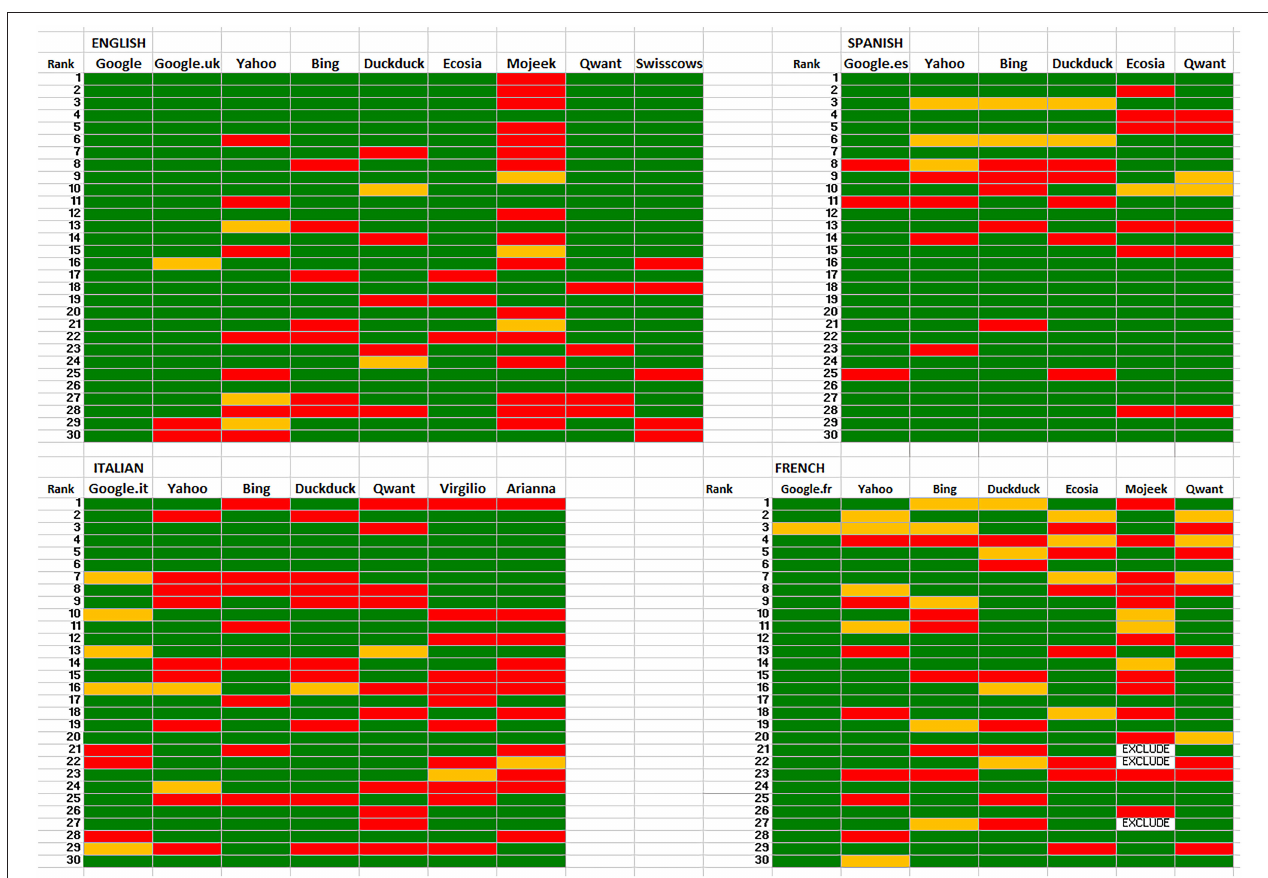
FIGURE 1 | Stance on vaccines in webpages returned by different search engines in four languages. The top 30 webpages returned in the SERPs are shown. Green, vaccine-positive, yellow, vaccine-neutral, red, vaccine-negative.